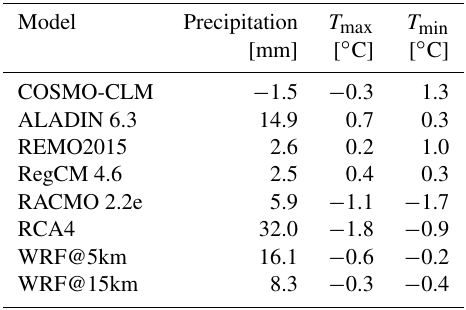
Table 4. Spatially and temporally averaged bias values of the monthly values of the meteorological